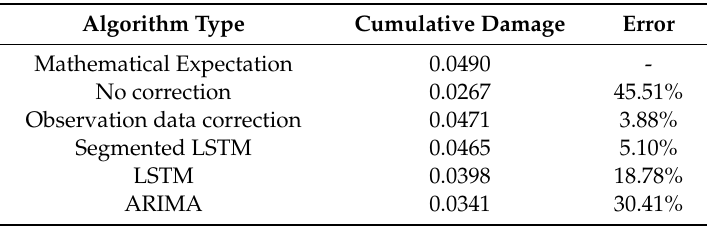
Table 7. Comparison of health